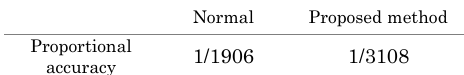
Figure 9. Adjusted points (opposite of side)